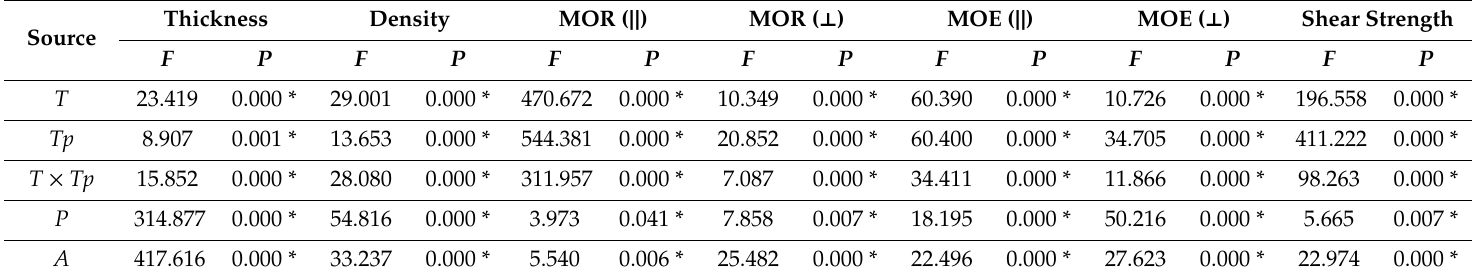
Table 2. ANOVAs of the variable parameters on the mechanical and physical properties of plywood panels.